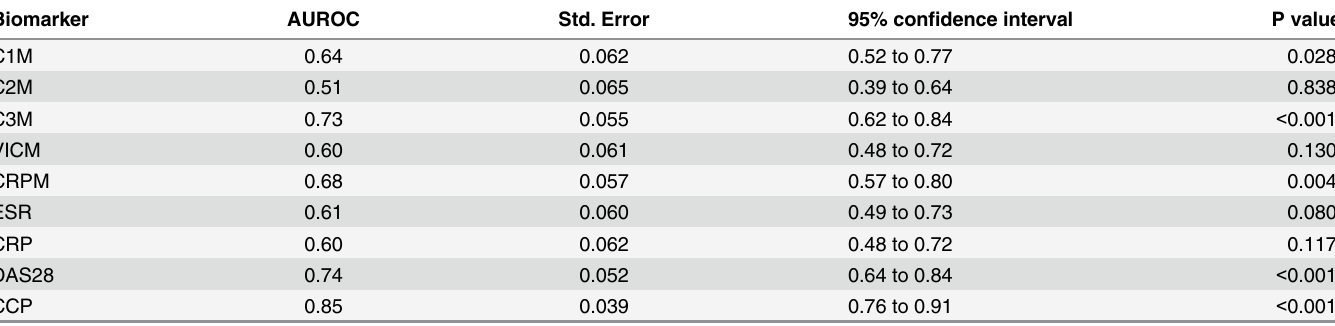
Table 2. Area under the receiver operating characteristic (AUROC) for discriminating between RA and UA baseline diagnosis. Biomarker